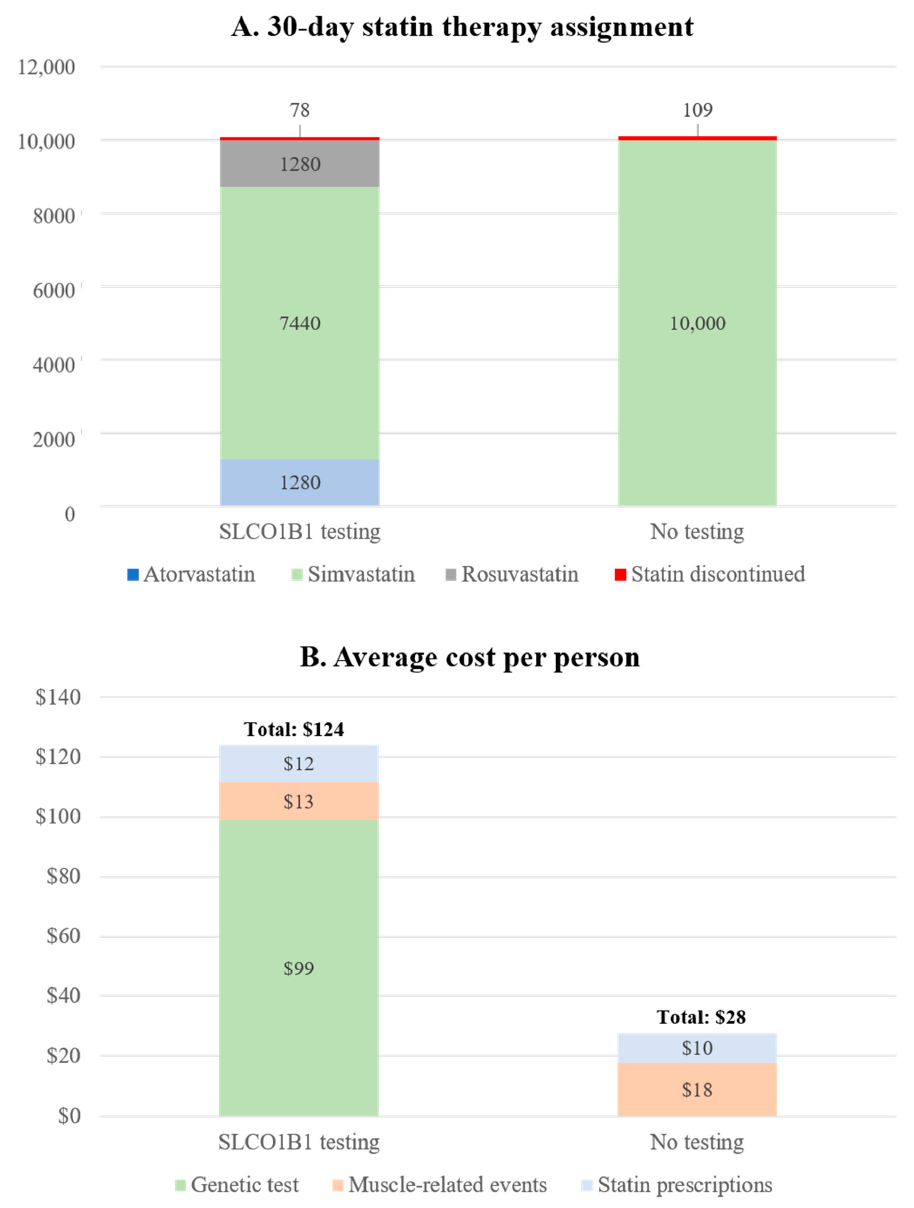
Figure 3. (A) Statin therapy assignments and (B) average cost per person at 30 days from modeling the best-case scenario. ( A ) The 30-day statin therapy assignments in a cohort of 10,000 veterans in the SLCO1B1 testing and no testing strategies. Possible statin therapies include atorvastatin, simvastatin, rosuvastatin, or statin discontinuations. Statin discontinuation is caused by statin-related myopathies and myalgias. ( B ) The average cost per person and cost sources for SLCO1B1 testing and no testing. Cost categories included genetic testing, muscle-related events, and statin prescriptions. Costs are reported in 2020 USD.